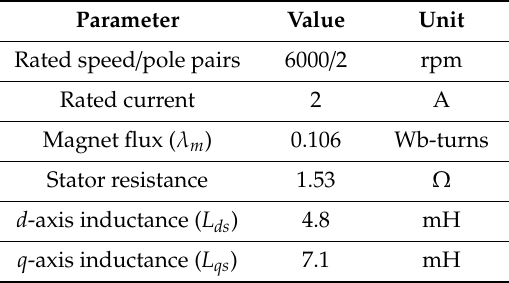
Table A1. Main motor